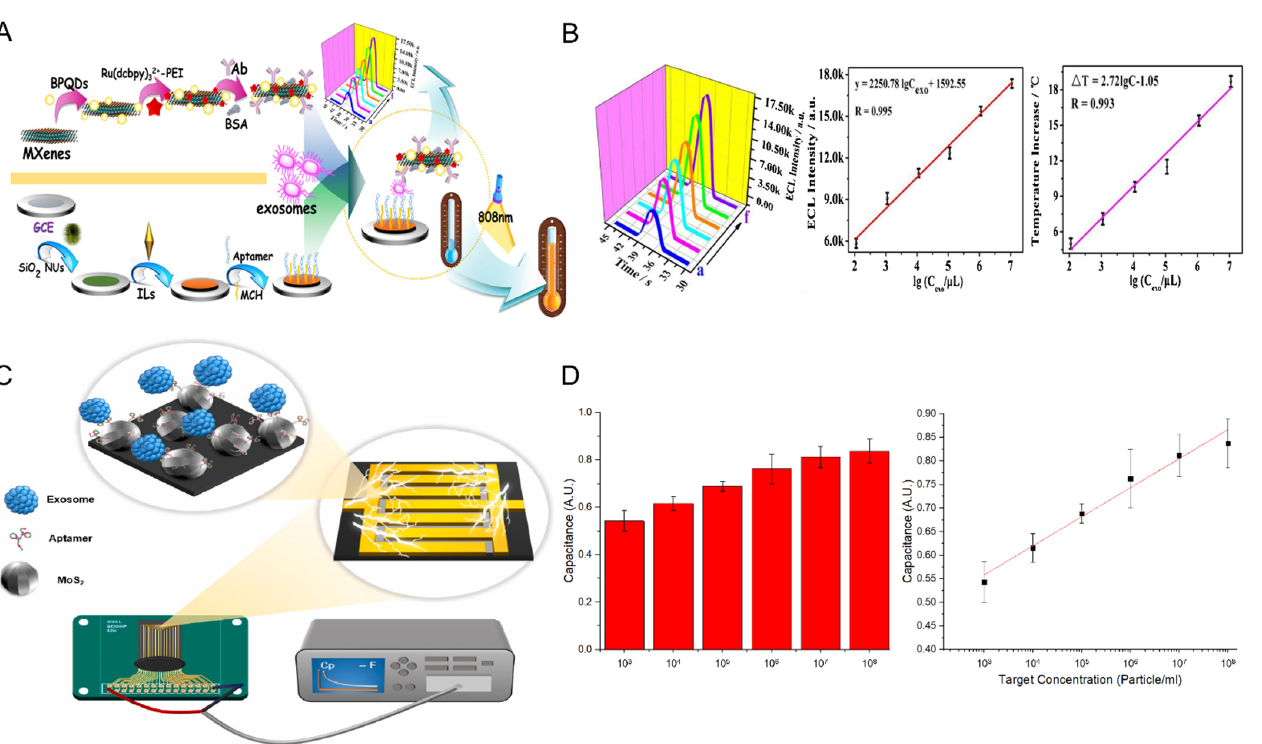
Figure 3. ( A ) Schematic diagram of ECL/photothermal dual biosensor composed of BPQD and MXene, ( B ) sensor performance evaluation under ECL and photothermal conditions, ( C ) schematic diagram of electric biosensor composed of MoS 2 and IDMGE, and ( D ) evaluation of sensor detection performance through exosome concentration versus capacitance response. This was reproduced with permission from [33,74], published by Elsevier, 2020 and 2022, respectively.